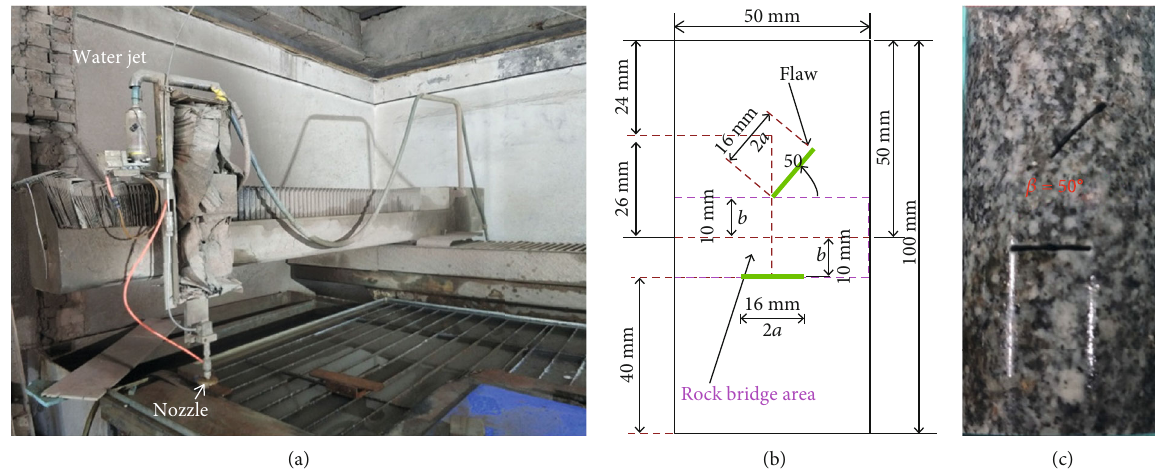
Figure 1: Preparation of the pre fl awed granite samples. (a) A water jet machine used to cut two fl aws in intact rock. (b) Geometry size of the two fl aws in rock samples. (c) Typical rock samples with an approach angle of 50 ° used to conduct mechanical